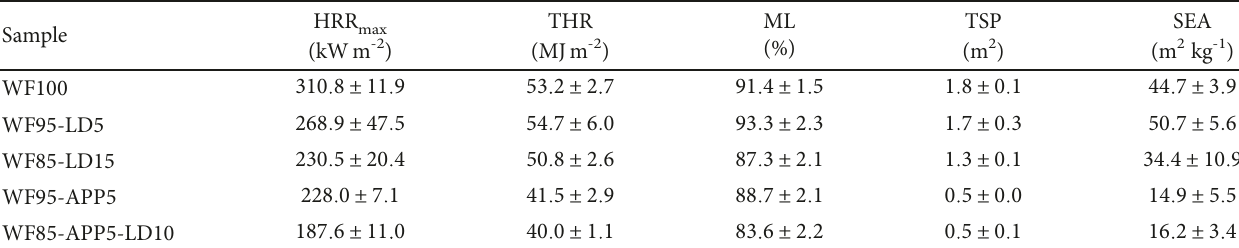
Figure 3: Photo of some of the prepared WFP, prior to the cone calorimeter test (a) and after combustion (b). Table 5: Average results obtained from cone calorimeter characterization of